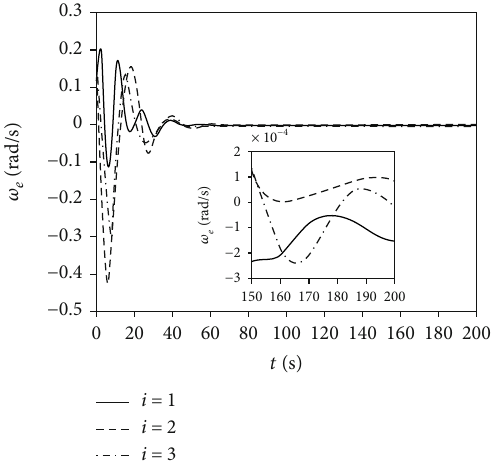
fi nite-time controller. R using the